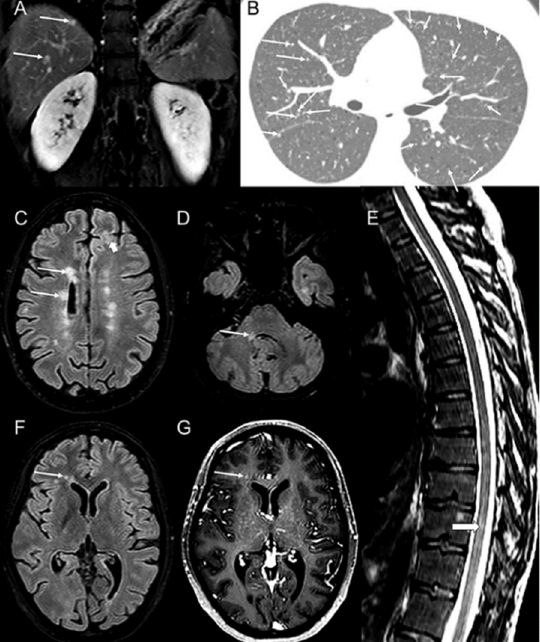
Figure 1. Abdominal MRI reveals hypervascular liver metastases (arrows A) from medullary thy- roid carcinoma on coronal T1 post-contrast administration image ( A ). Chest CT ( B ) shows multiple micronodular lung metastases (arrows B). Brain MRI reveals multiple hyperintense and demyelinat- ing lesions on axial FLAIR images (C,D ) in the periventricular white matter (arrows C), in the sub- cortical white matter (thick arrow C), and in the right middle cerebellar peduncle (arrow D). There is also a lesion (thick arrow E) in the thoracic spinal cord, as seen in the sagittal T2 image ( E ). One lesion seen on axial FLAIR image ( F ) near the frontal horn of the right lateral ventricle (arrows F, G) enhances axial T1 post-contrast image ( G ).